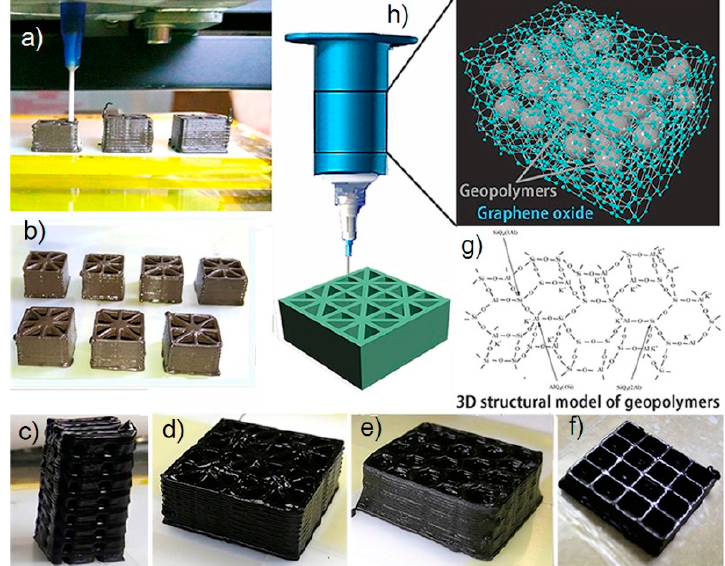
Figure 21. ( a – f ) 3D printing process and some 3D printed structures. ( b – f ) The colors of the printed samples turn from brownish to blackish when the GO loading increased. ( g ) The chemical structure of geopolymer, and ( h ) schematic diagrams of the painting process and the composite structure are also showed. Reproduced from [209], with permission from Elsevier, 2017.